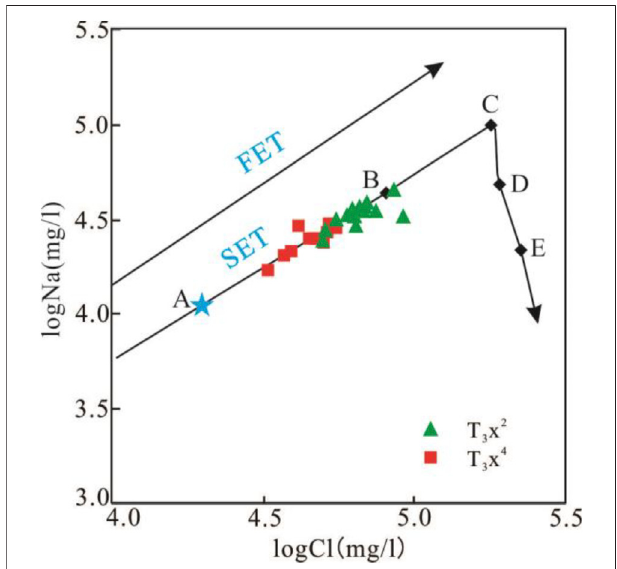
FIGURE 6 | Relationship between the logCl-logNa and SET and FET of the formation water of the Xujiahe Formation in the middle part of the western Sichuan Depression. Notes: SET and the positions of points A, B, C, D, and E refer to Carpenter (1978). The meanings of points A, B, C, D, and E are the same as in Figure 4